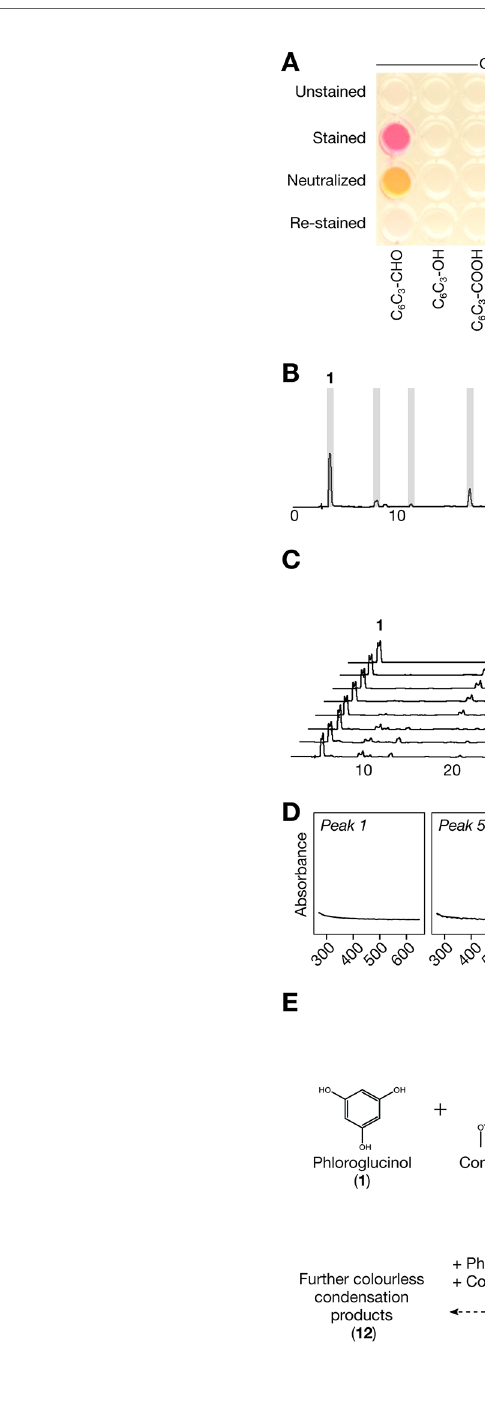
FIGURE 1 | Reactivity of phenolic monomers to the Wiesner test. (A) Image acquired on the reactivity of 2.5 nmol of compound solubilized in methanol 1 min after adding either 6 M HCl (unstained), 0.5% phloroglucinol/6 M HCl (stained), 0.5% phloroglucinol/6 M HCl followed by 1 min neutralization with 6 M NaOH (neutralized) and followed by re-staining for 10 min in 6 M HCl (re-stained). (B) LC pro fi les of coniferaldehyde reaction to the Wiesner test in 50 mM HCl as well as the fractions collected in gray. (C) LC pro fi les showing the time-stability of coniferaldehyde reaction to the Wiesner test in 0.5% phloroglucinol/6 M HCl. The solutions were neutralized with 6 M NaOH before injection. All the chromatograms have the same absorbance scale. (D) Absorbance spectra of collected fractions before (dotted lines) and after addition of 6 M HCl (solid lines). Note that fraction 9 is the acid-dependent chromophore indicated by the purple background (hue = 319°). (E) Proposed chemical condensation reaction for the Wiesner test. Different tautomeric resonance forms of the carbocation intermediate are shown in Figure S3E